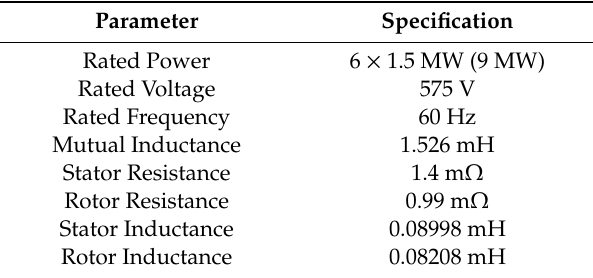
Table 3. Specifications of the wind turbine.